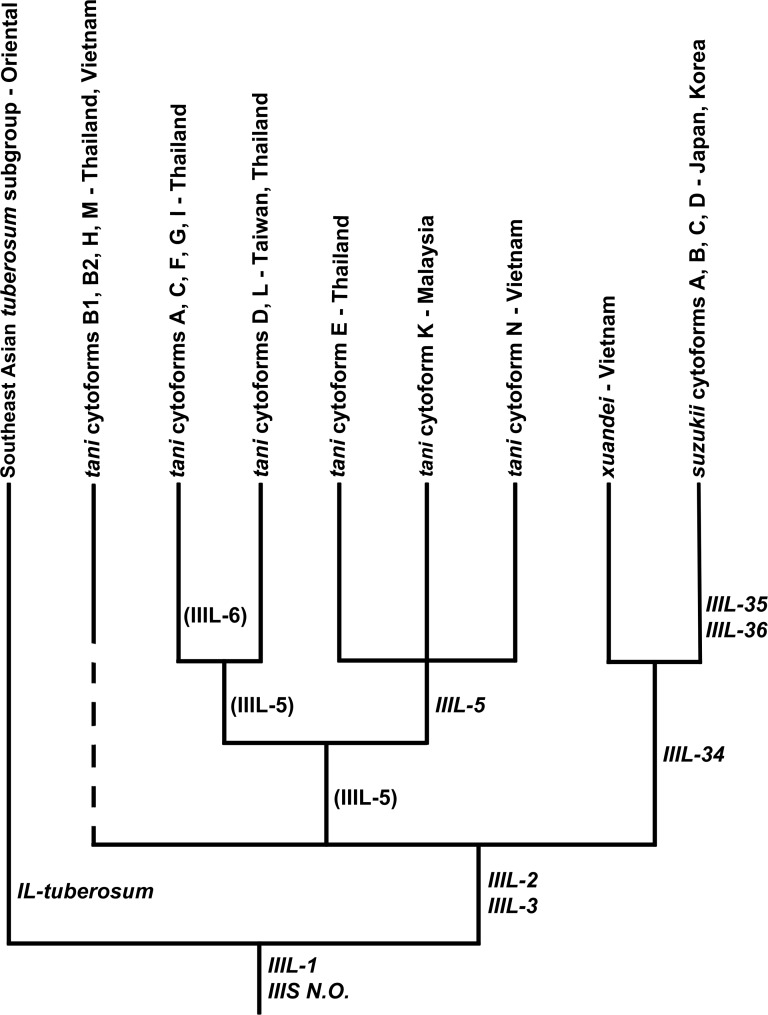
Cytophylogeny of the Simulium tani complex.The outgroups (Simulium erythrocephalum and Simulium vittatum) are not shown. Italicized rearrangements are fixed; polymorphisms are in parentheses. The dashed line for S. tani B1, B2, H, and M indicates that these taxa have no defining rearrangements. The 4 cytoforms of the northern S. suzukii lineage have been resolved previously [24], and the Southeast Asian S. tuberosum subgroup is resolved in Fig 14.